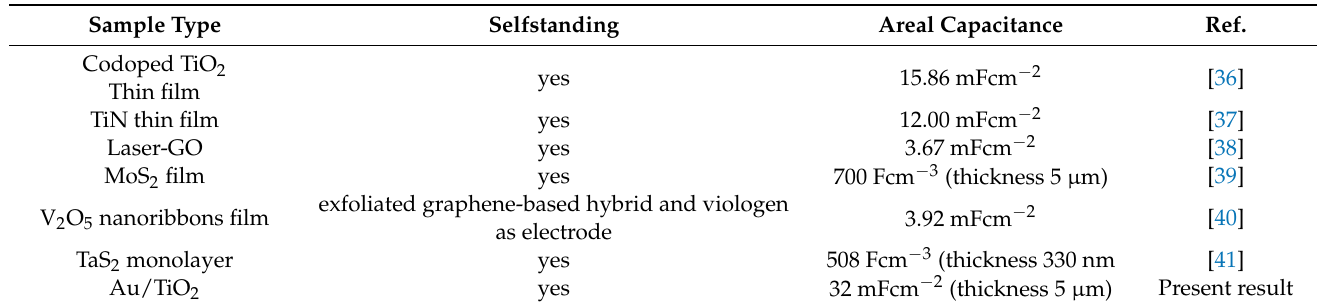
Table 1. Comparison with similar thin-film electrodes, in terms of the type, selfstanding, and areal capacitance.